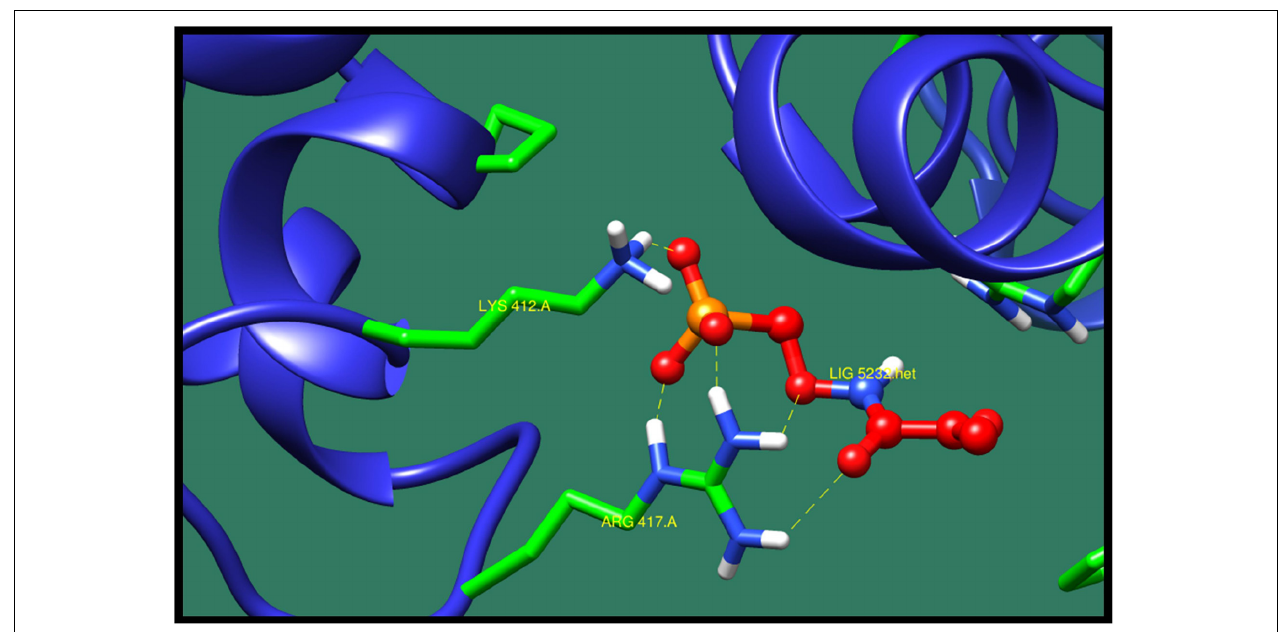
FIGURE 4 | Interaction of chromosomal replication initiator protein DnaA with ZINC71782058 (colored in red). The interacting residues (green) are shown bonding (dotted lines) with the ligand. TABLE 7 | Transcriptional regulator CtsR and its interaction profile with docked compounds their ZINC ID, minimized energy, number of interactions, dock score, and interactive residues. ZINC ID Number of interactions Interacting